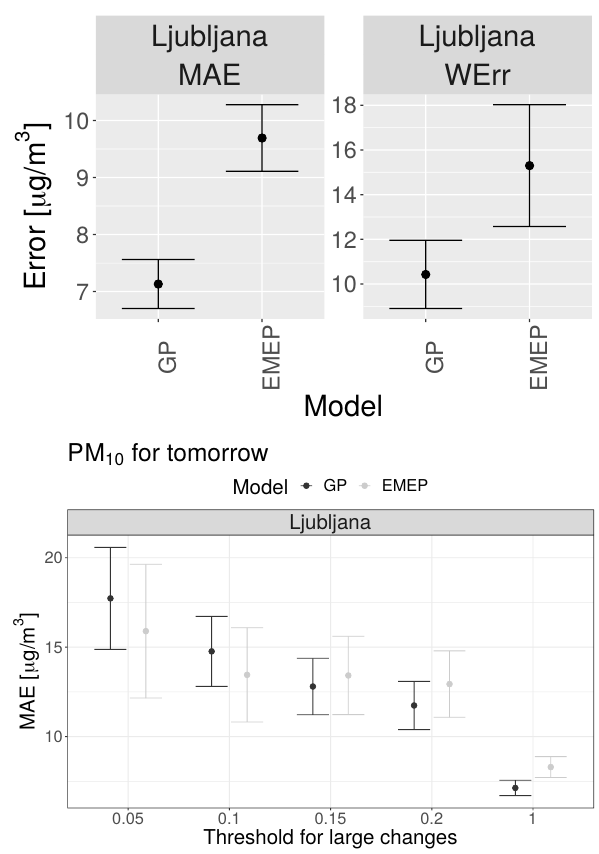
Figure 9. The top left figure shows MAE for GP and EMEP MSC-W models for PM 10 prediction for the following day in Ljubljana, top right figure shows WErr for the same models. The lower figure shows MAE for different GP and EMEP MSC-W models for different percentages of highest values ∆ C(2